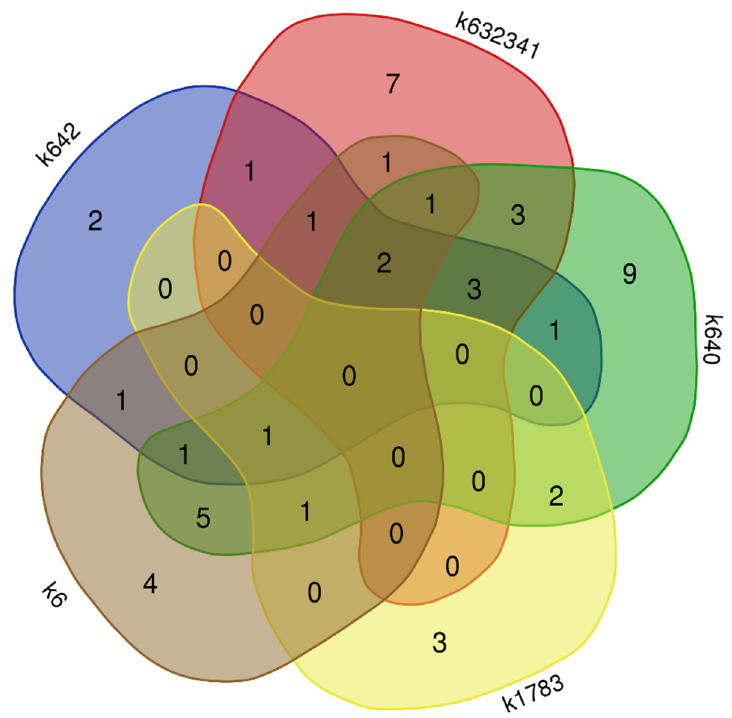
Figure 6. Venn diagram of bioactive compounds between V. unguiculata accessions.